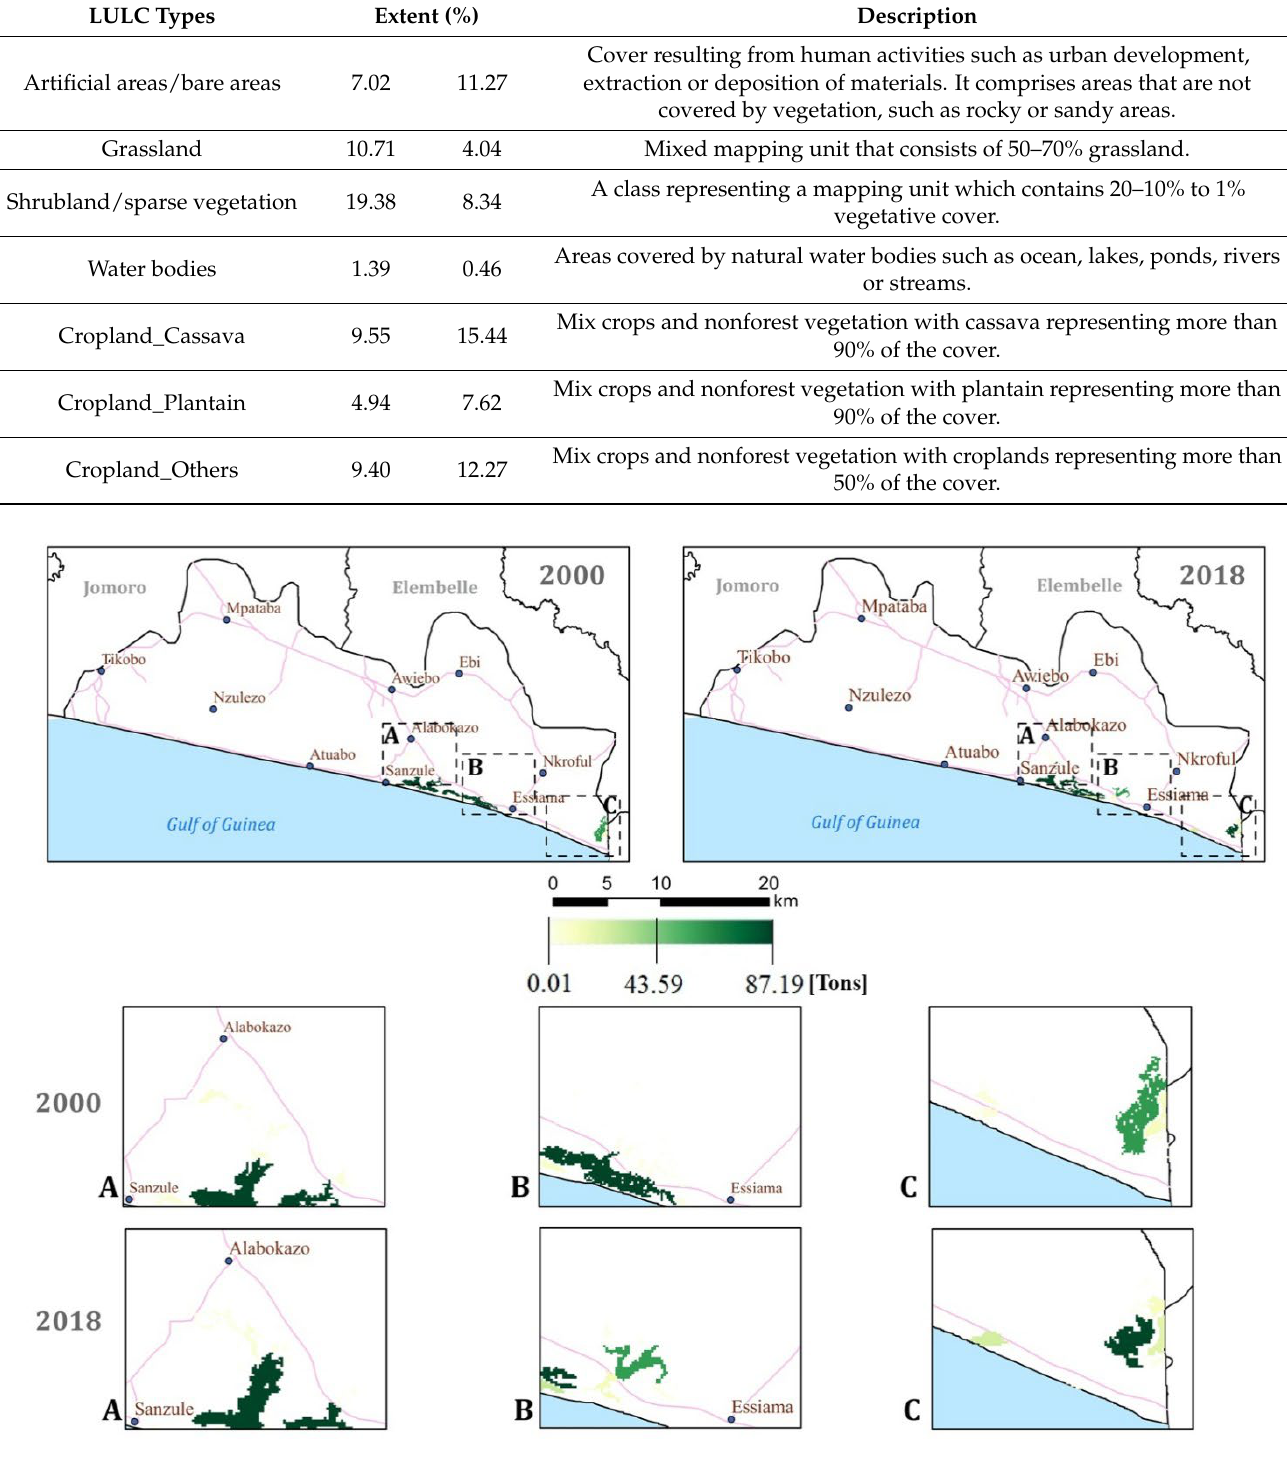
Figure 4. Quantities of mangrove fuelwood supply and distribution across the landscape in 2000 and 2018; ( A – C ) compares the spatial and temporal distribution of mangrove fuelwood supply potential in segments of the landscape.